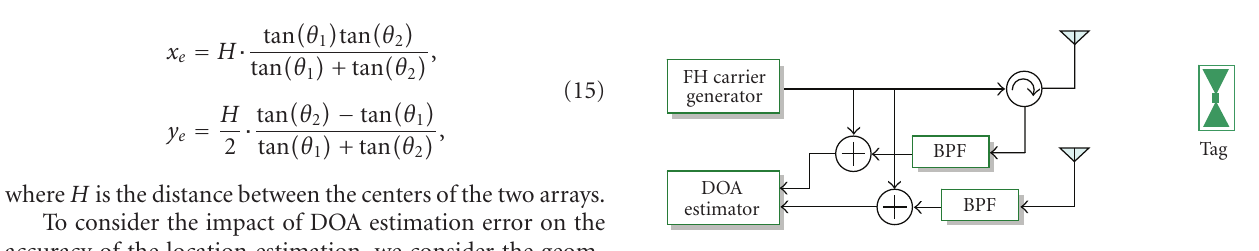
Figure 9: Block diagram of the simulated